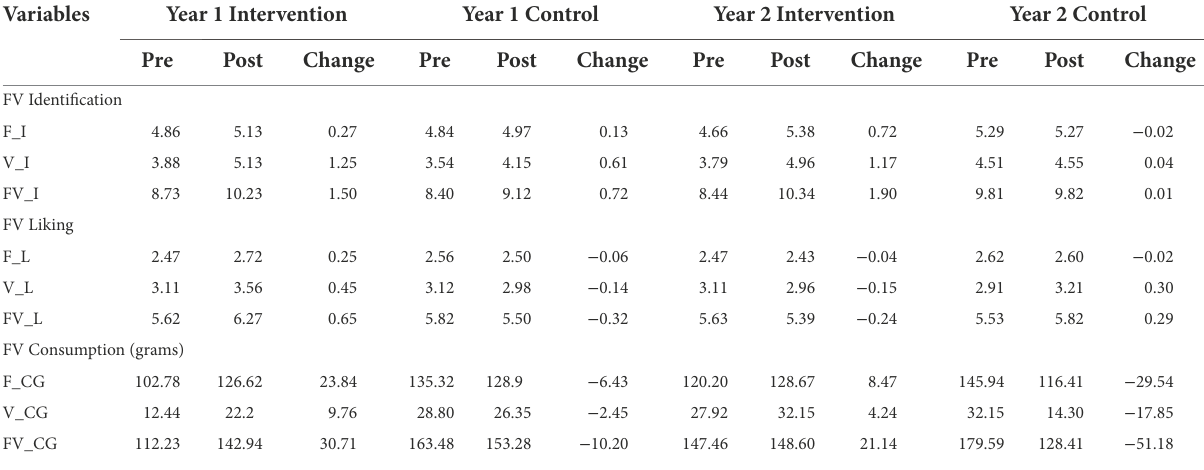
TABLE 5 Pre-post sample mean scores and their change for intervention and no-intervention groups in Year 1 and 2 for each outcome ( n = 285).